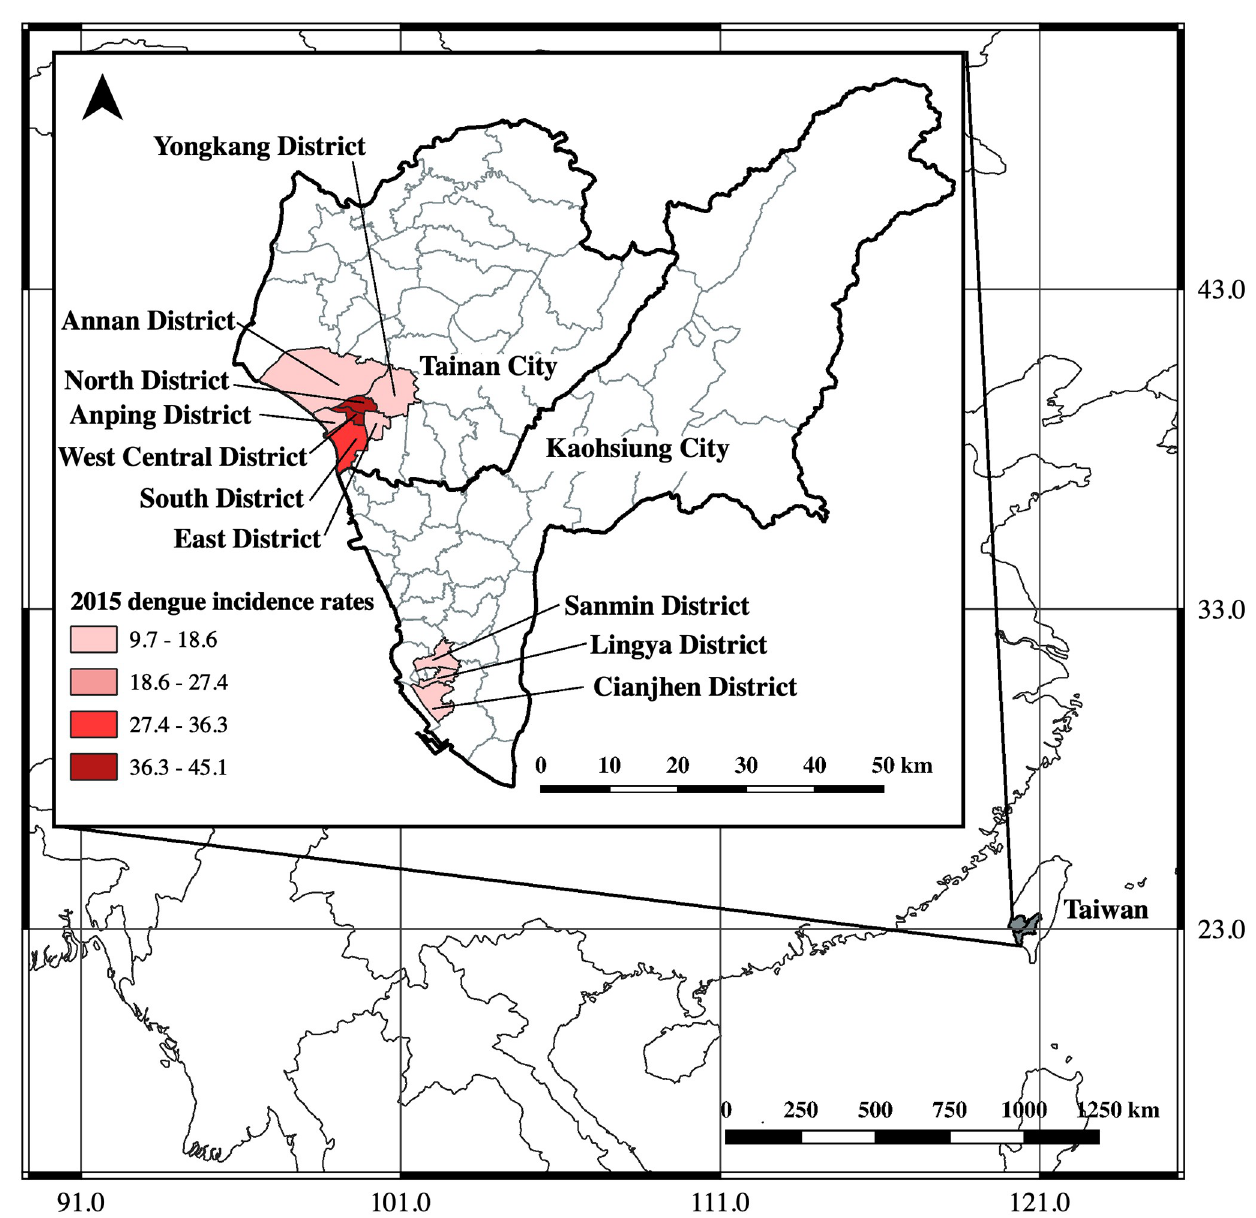
Fig 1. Location of Taiwan and map of study areas in Kaohsiung City and Tainan City. The areas shaded in grey color represent the study districts. The map was generated using QGIS software (QGIS Development Team, version 3.10, https://www.qgis.org.en/site/). The world (https://www.diva-gis.org/ Data) besemap was obtained from DIVA-GIS, while basemaps of the Taiwan cites (https://data.gov.tw/dataset/7442) and Taiwan districts (https://data.gov. tw/dataset/7441) were all collected from the government’s open data platform.